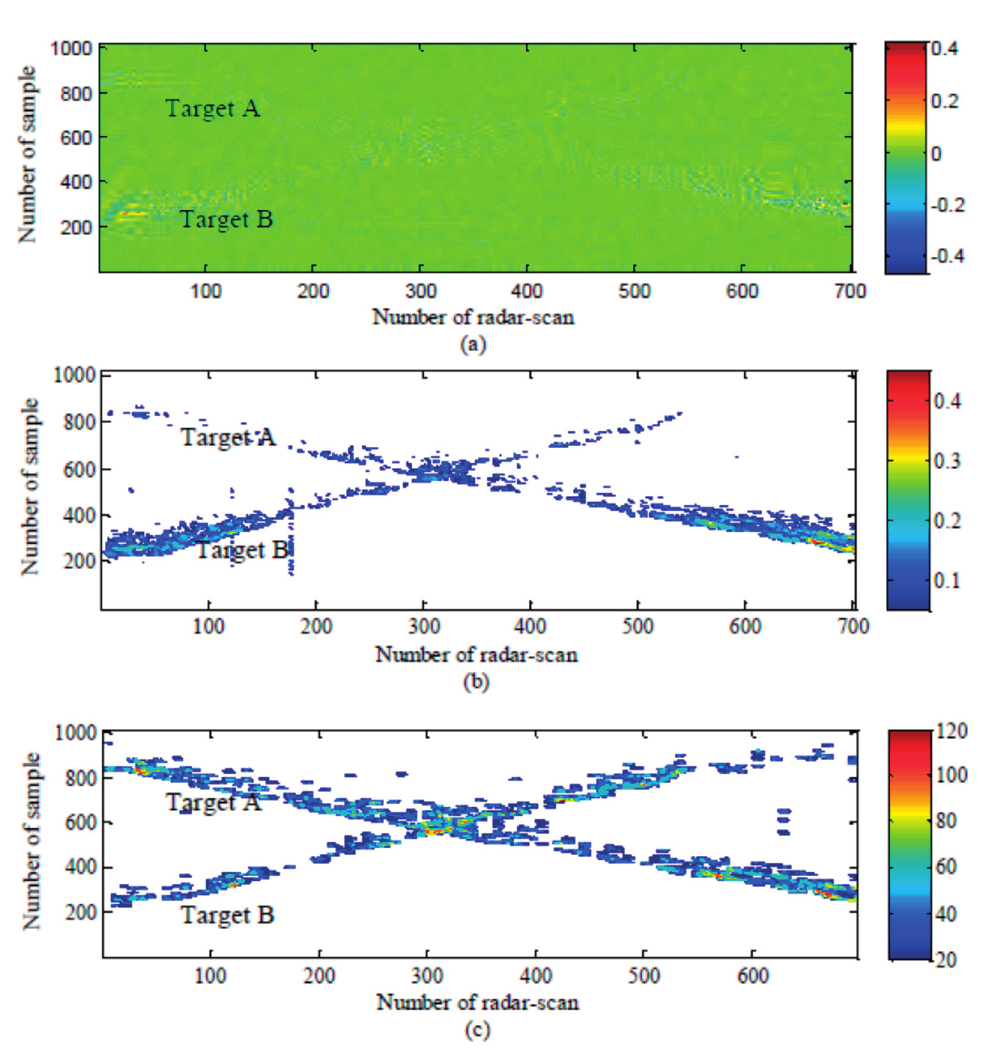
Figure 8. Radargrams: ( a ) before detection; ( b ) after detection with the conventional CLEAN algorithm; and ( c ) after detection with the modified CLEAN